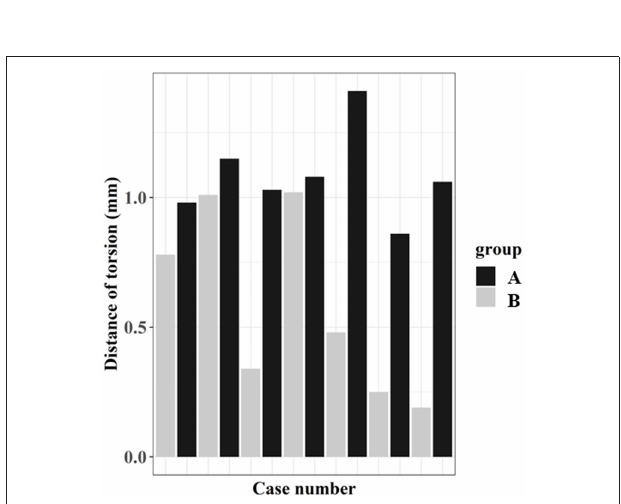
FIGURE 9 | Osteotomy torsion distance measurement for the two groups. Osteotomy torsion is defined as the distance of the center of the two circles superimposed over the osteotomy from the medial and lateral aspects.